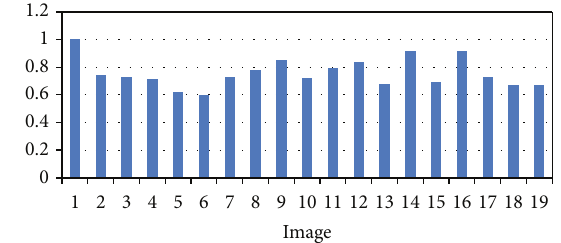
Figure 13: Surface registration accuracy wih intensity correction. Unit: mm.